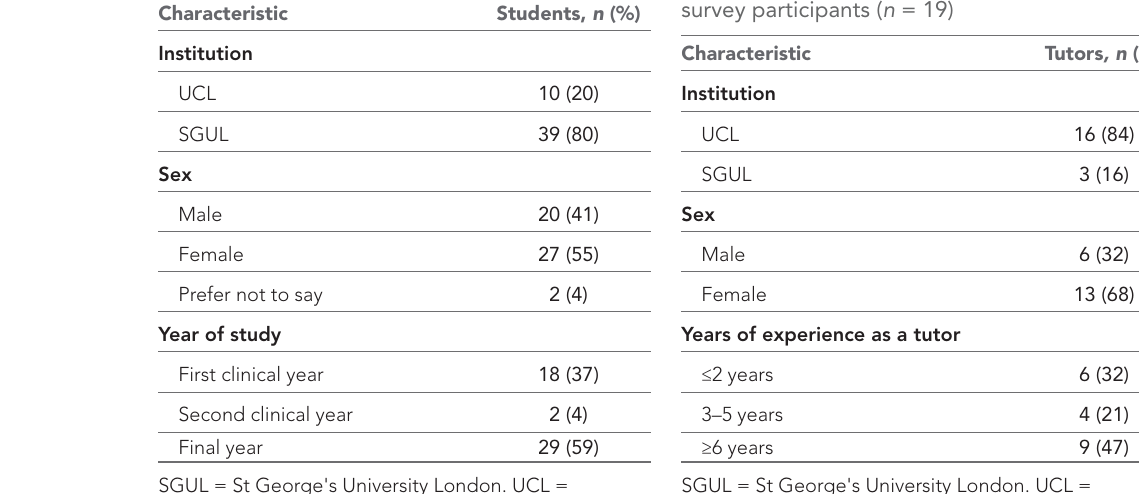
Table 1 Characteristics of the student research